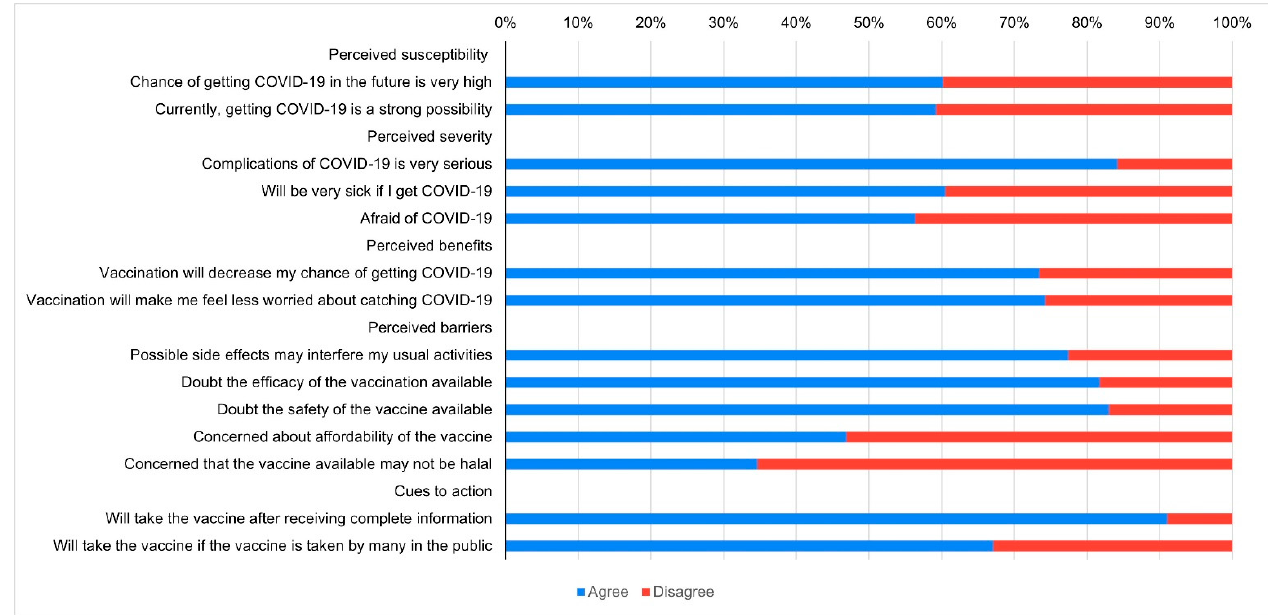
Figure 1. COVID-19-related health beliefs in Bangladesh.